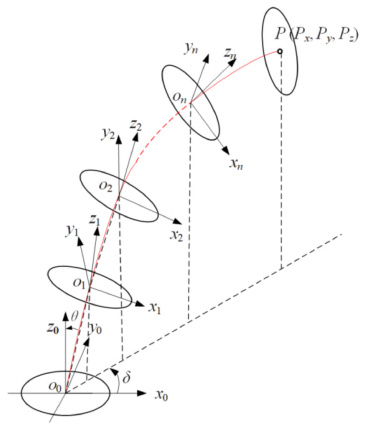
Figure 3. Kinematics model of the flexible surgical